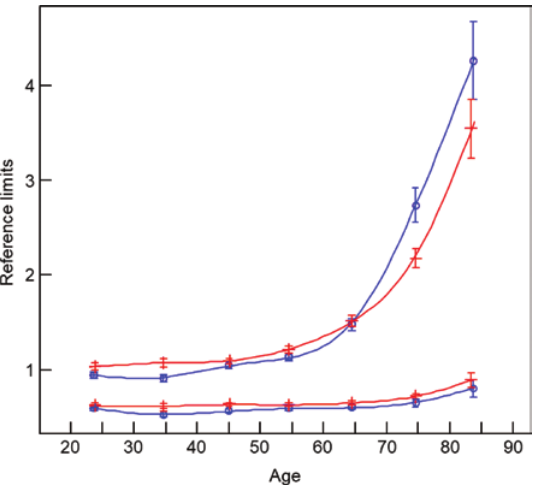
Figure 4: Reference limits of serum cystatin C (mg/L) depending on age (years) separated by sex. Lower lines represent the 2.5 th percentile, upper lines the 97.5 th percentile, red lines represent men (n = 6131) and blue lines women (n = 5266). The data were obtained from a primary health care laboratory (laboratory